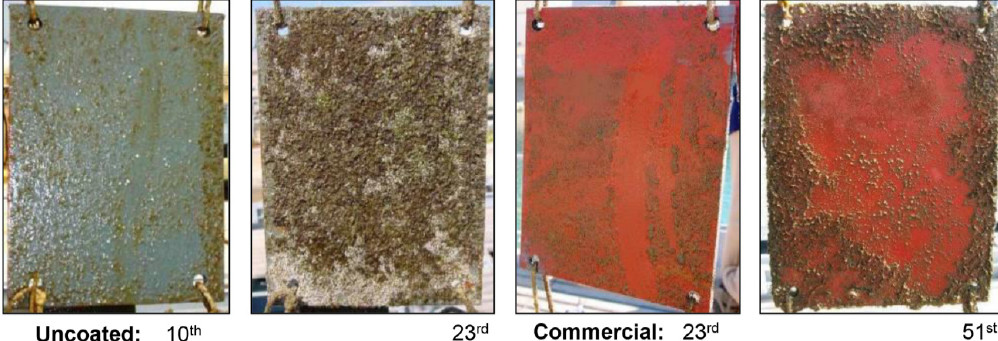
Figure 5. Appearance of plates uncoated and coated with commercial paint and their time of immersion in marine